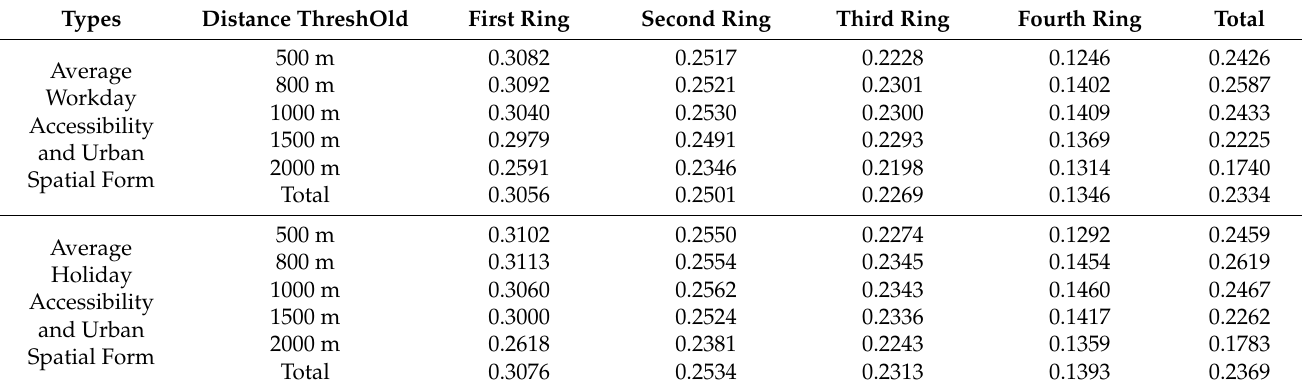
Table 4. Average degree of spatial coordination in various service areas and